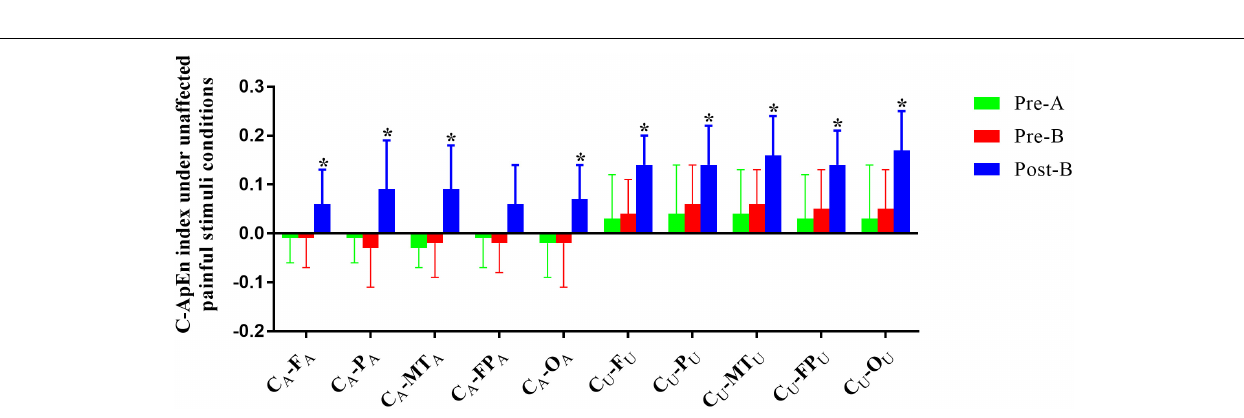
FIGURE 5 | C-ApEn index under the affected painful-stimuli condition. * p < 0.05 was considered statistically significant.